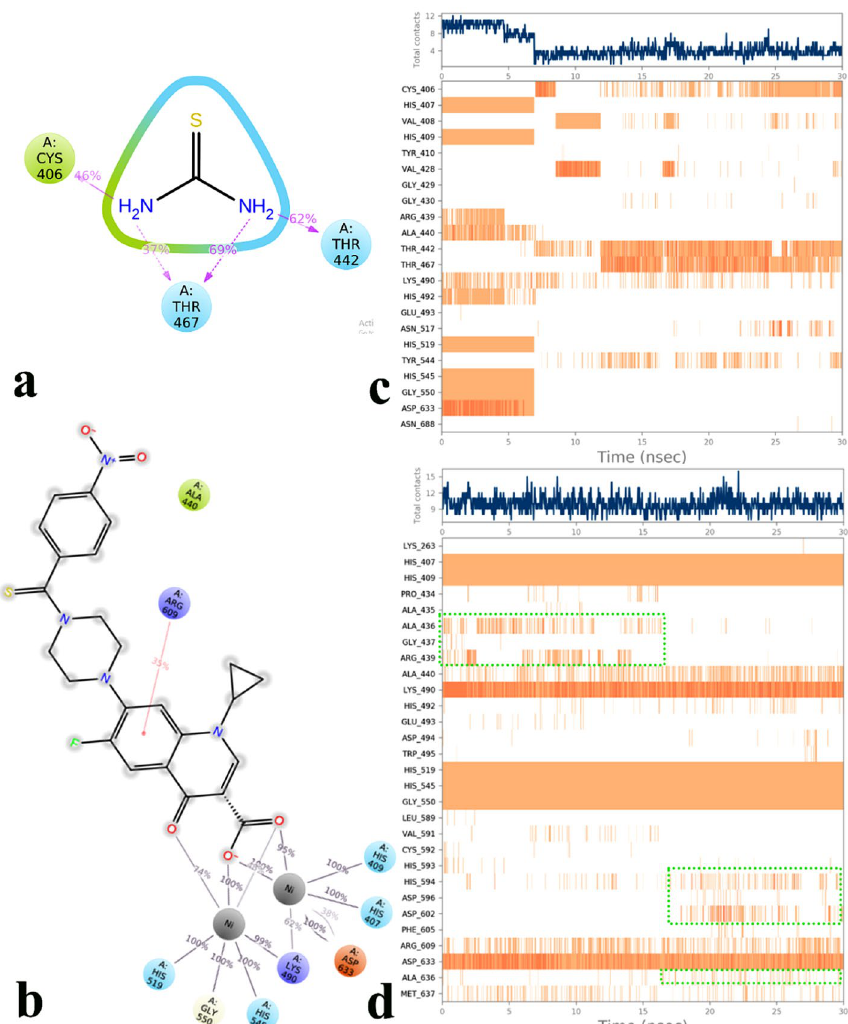
Figure 8. 2D representation of ligand-residue interactions that occur at least 30% of simulation time at the equilibrated phase of MD simulation which include urease bound-state with thiourea ( a ) and compound 3n ( b ). Timeline rendering of interacting residues during the whole simulation time in urease complexed with thiourea ( c ) and compound 3n ( d